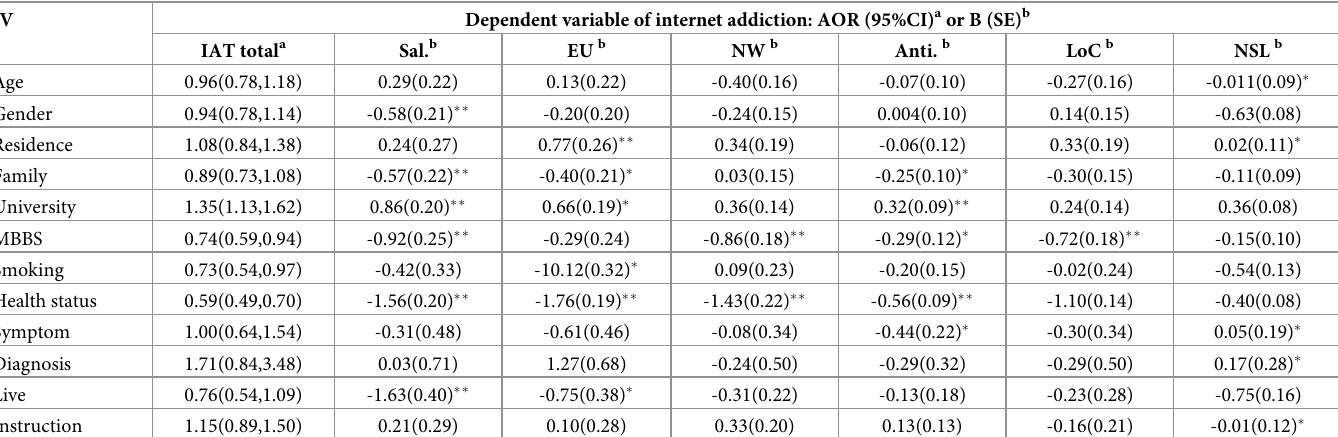
Table 3. Predictors on internet addiction (N =